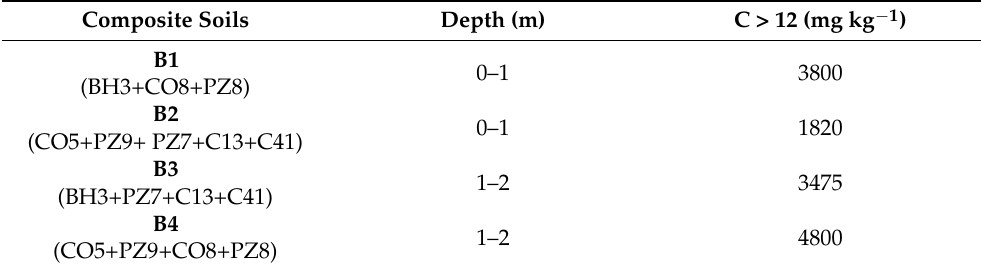
Table 3. Composition of the four soils obtained by combining the sampled